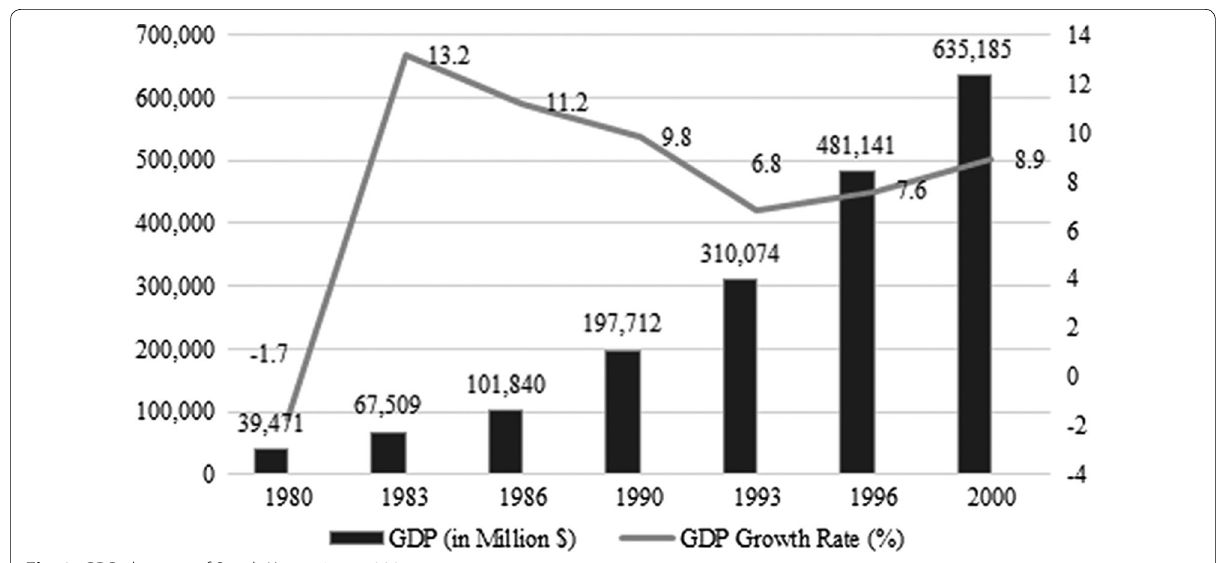
Fig. 2 GDP changes of South Korea since 1980